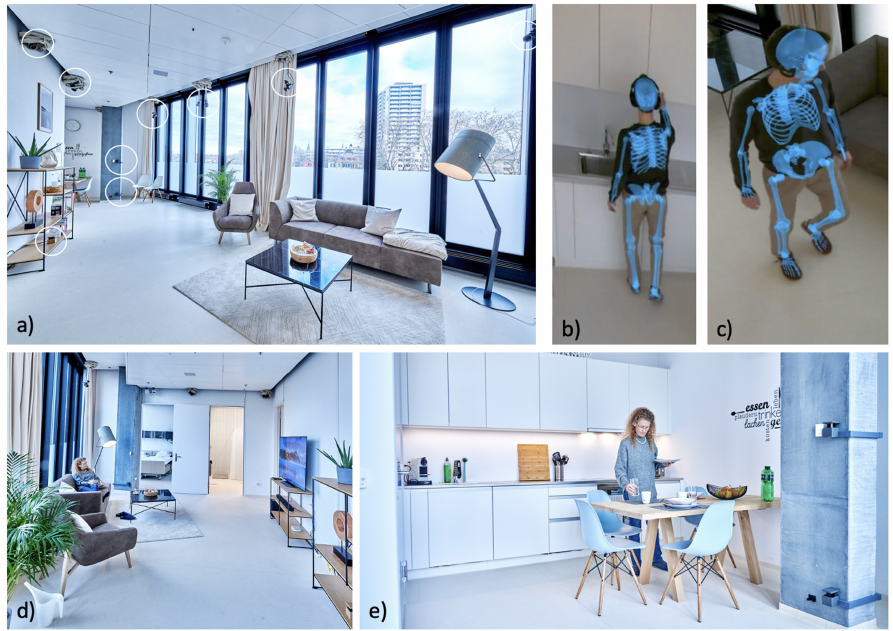
Figure 2. Marker-free motion tracking in the sensor-equipped apartment (NeuroTec Loft) University Hospital Inselspital. The living room ( a , d ) and the kitchen ( e ) are equipped with 13 cameras that allow to fit a 54-point skeleton model onto the test-person’s body ( b , c